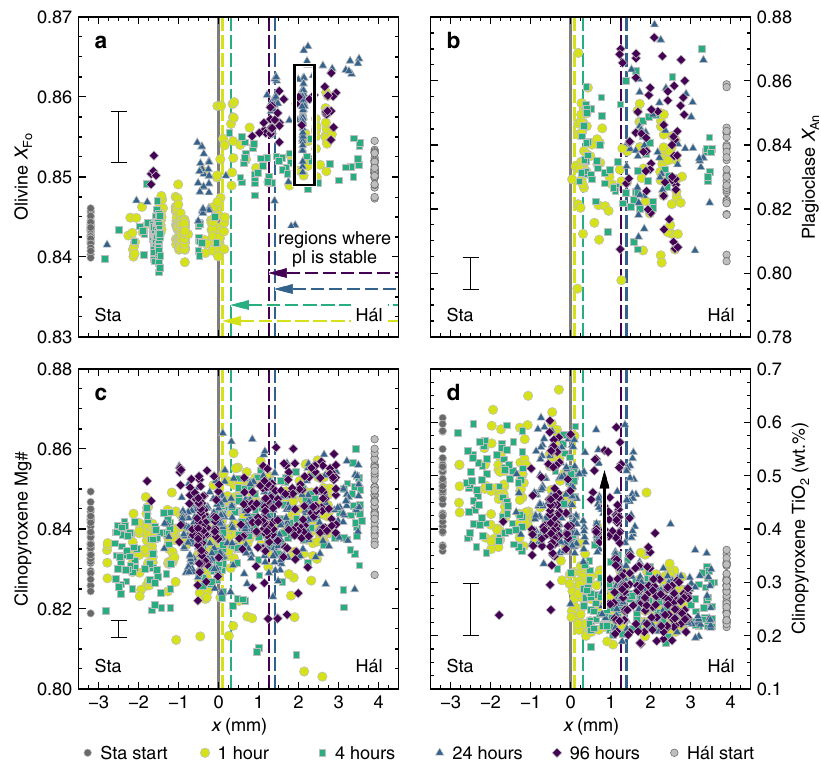
Fig. 8 Mineral compositions in the products of magma – magma reaction experiments. The positions of interfaces between juxtaposed magma cylinders are shown as vertical grey lines. Regions of the experimental products within which plagioclase (pl) is stable are shown with dashed vertical lines and horizontal arrows. Mineral compositions in the products of synthesis experiments are shown with grey symbols. Hál and Sta refer to Háleyjabunga and Stapafell lava analogues, respectively. Characteristic 2 σ analytical uncertainties are shown. a Distribution of olivine compositions across the products of magma – magma reaction experiments summarised in terms of olivine forsterite content [ X Fo , where X Fo = Mg/(Mg + Fe) on molar a basis]. Steps in X Fo across interfaces between magma analogues re fl ect the higher FeO* content of the incompatible element-enriched Stapafell lava analogue with respect